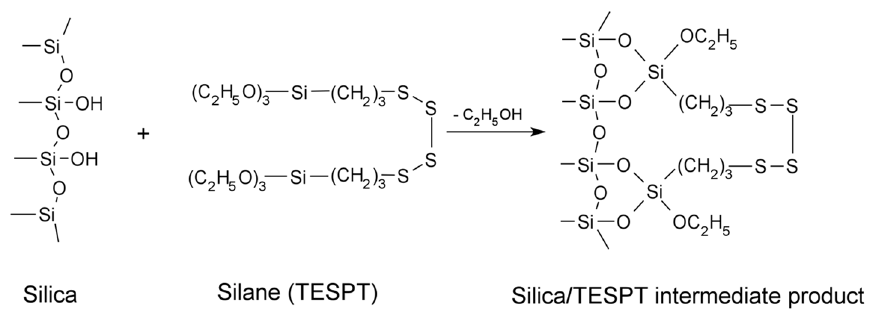
Figure 8. Chemical reaction between silica and silane.